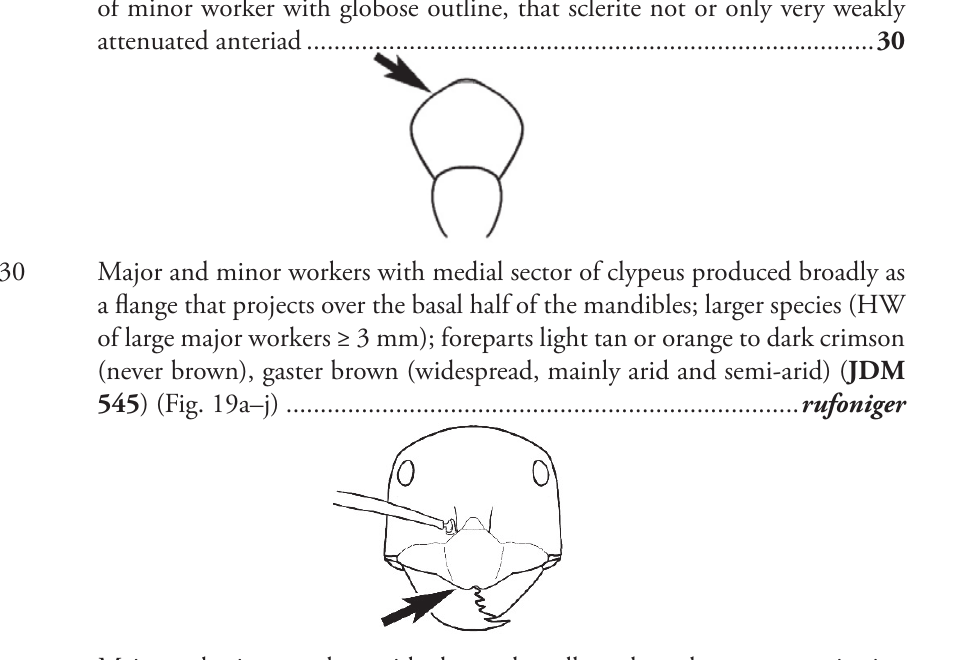
– Major and minor workers with clypeus broadly and gently convex, projecting over base of mandibles only; smaller species (HW of large major workers ≤ 2.3 mm); foreparts mostly brown, but can be black to light reddish-brown ....... 31